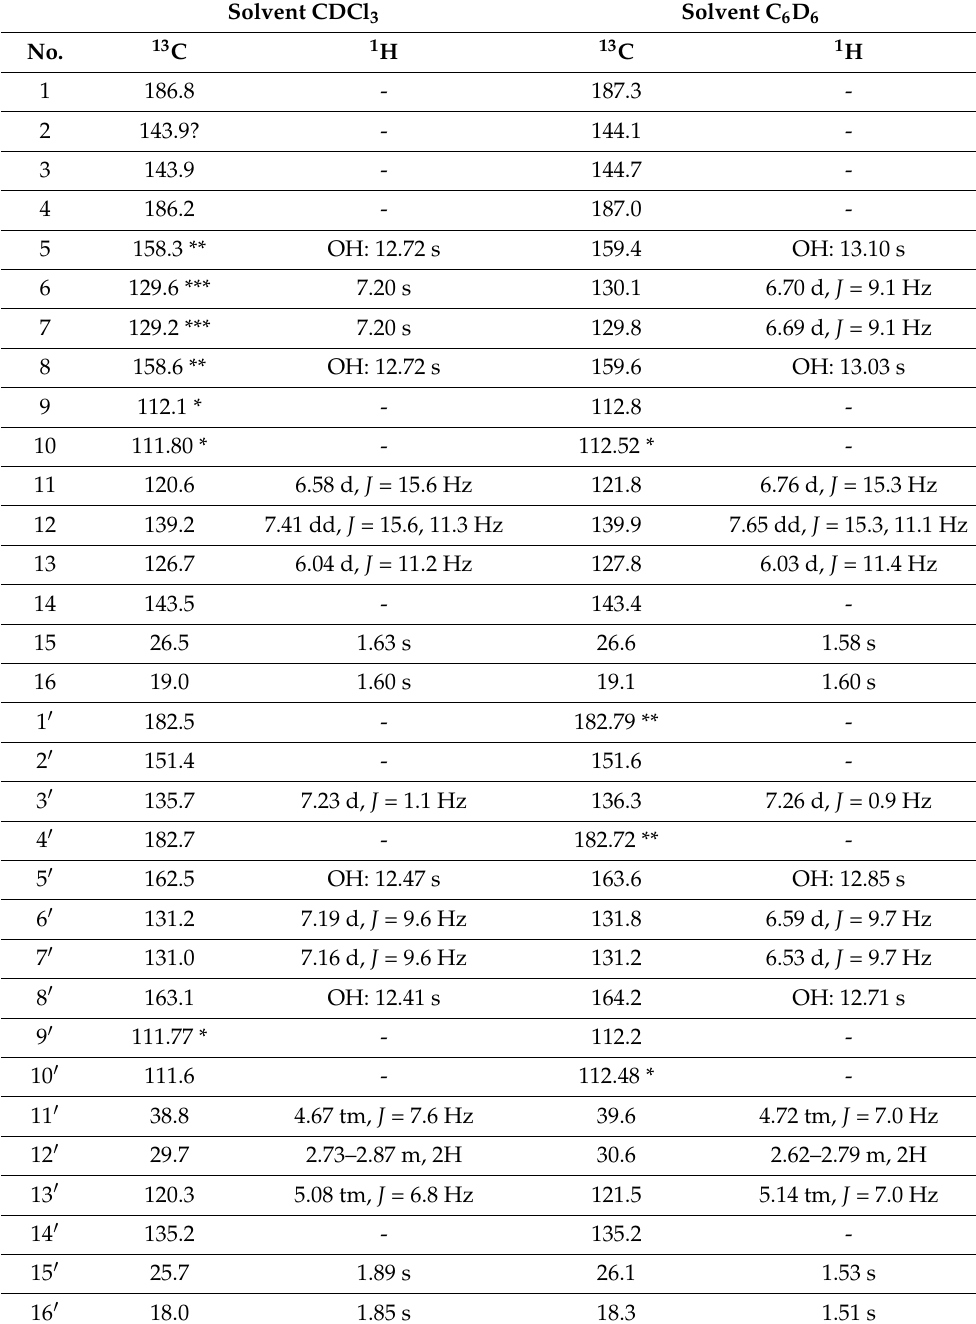
Table 1. NMR data of SK119, measured in CDCl 3 and benzene-d 6 . *, **, *** Peaks with the same symbol may be interchanged within column. For numbering, see Figure